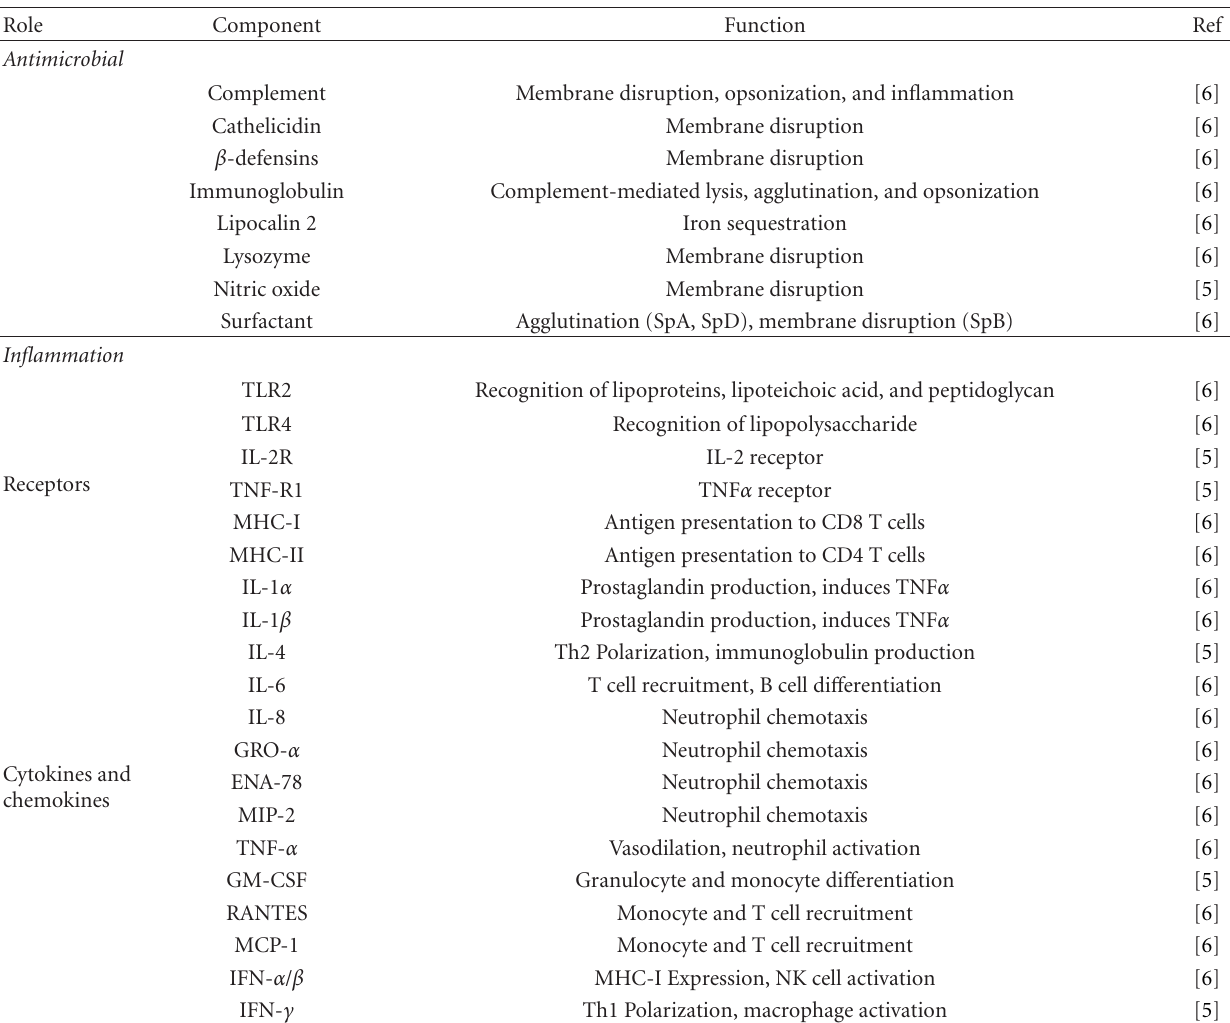
Table 1: Immunomodulatory roles of type II alveolar epithelial